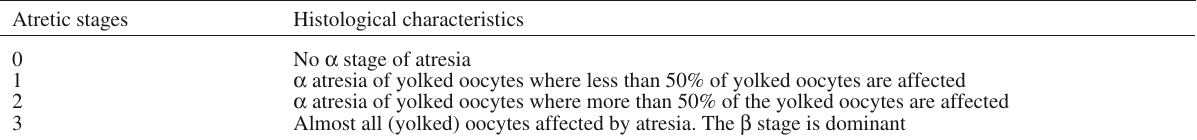
Table 2. – Histological staging criteria of atresia in ovaries of the common kilka (according to Hunter and Macewicz 1985b). Histological characteristicsAtretic